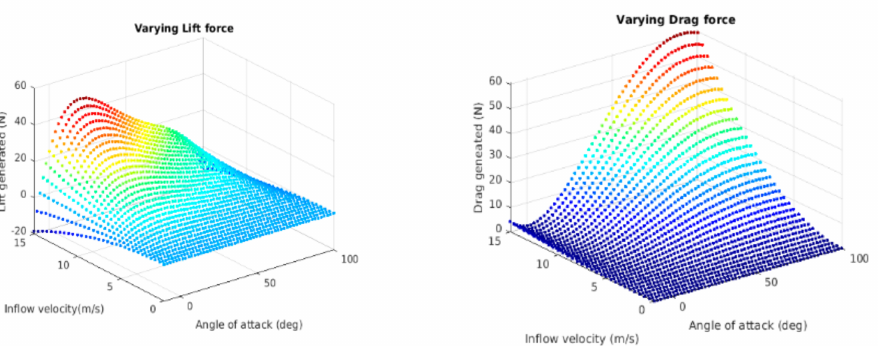
Figure 9. Variation of lift and drag forces with change in the AOA and airflow